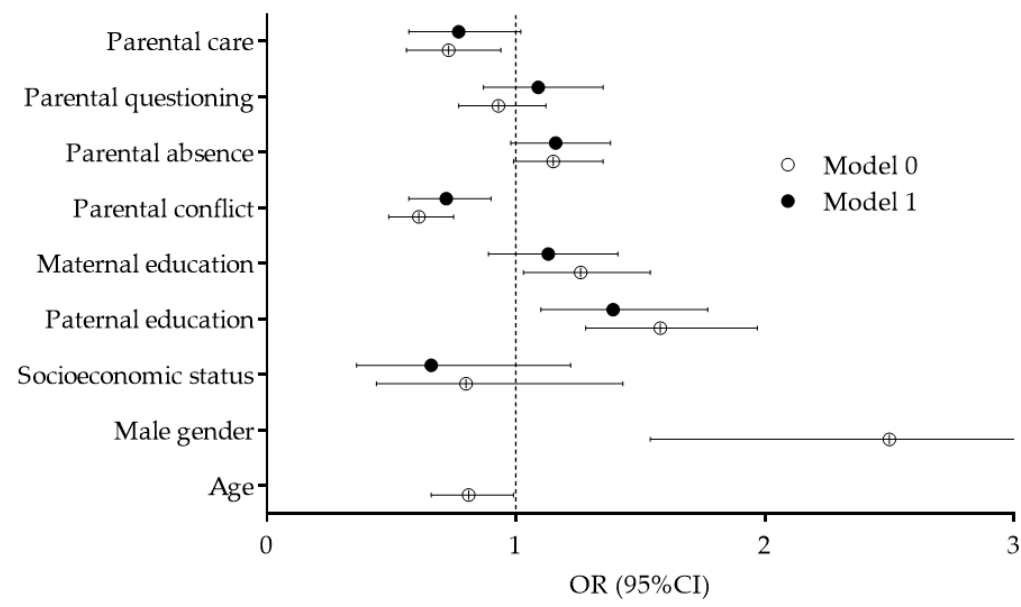
Figure 3. Correlates of sufficient physical activity levels before COVID-19 pandemic (Model 0 — crude logistic regression model non-controlled for covariates, Model 1 — logistic regression controlled for gender and age).